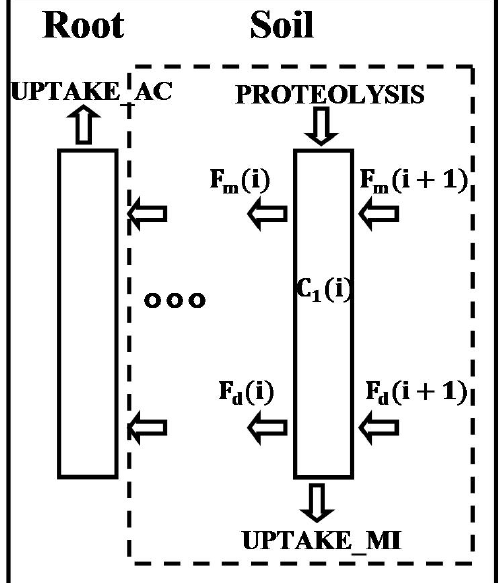
Fig. 2. Schematic representation of modeling amino acid transporta- tion in soil and uptake by plants: the roots’ surrounding soil is di- vided into many thin subcylinders. This is a vertical slice picture of i th sub-cylinder from the root surface. C 1 (i) is concentration of amino acid in soil solution in the subcylinder. F m (i) and F d (i) are mass flow and diffusion of amino acid, respectively. The supply rate of amino acid is calculated by the discrepancy between proteolysis and microbial uptake (Lipson et al.,